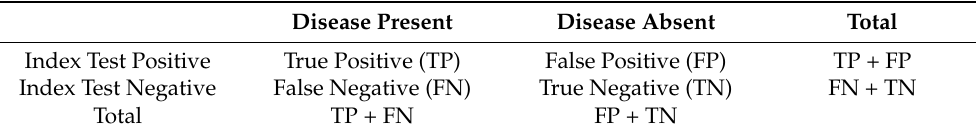
Table 2. Reference